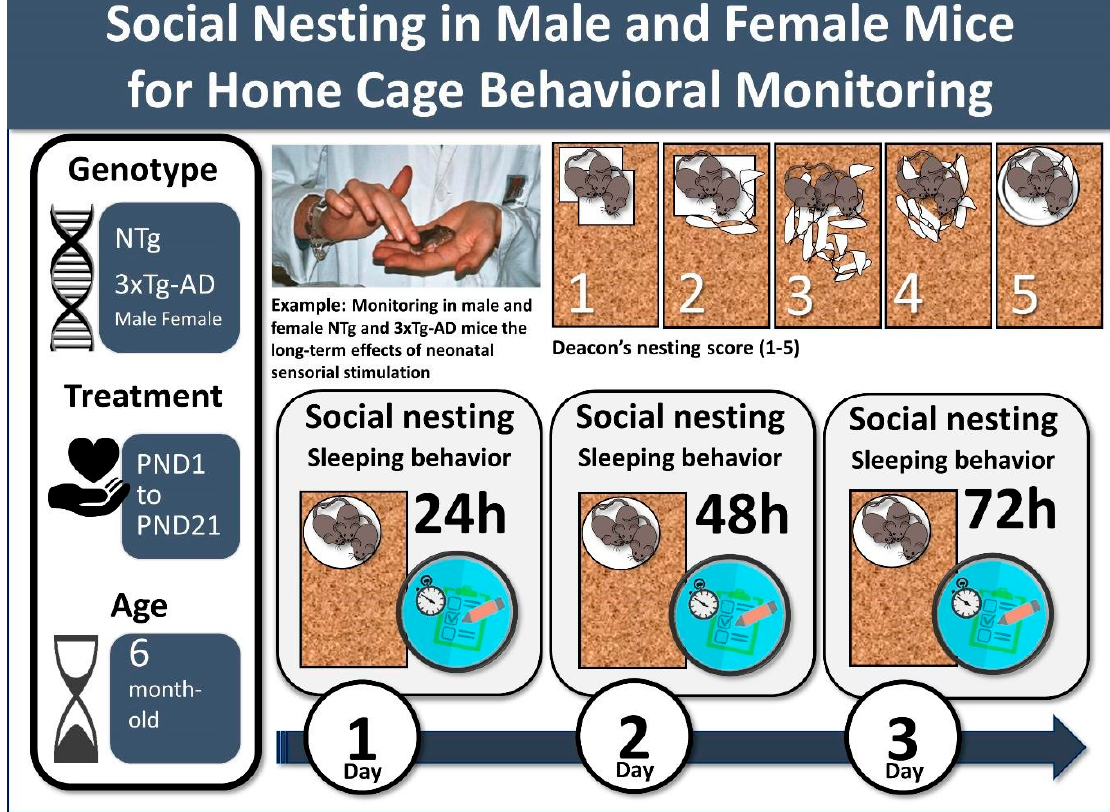
Figure 1. Social nesting in six-month-old male and female mice for home-cage behavioral monitoring in normal (NTg, non-transgenic) and AD-pathological aging (3xTg-AD mice), and the assessment of the long-term effects of neonatal tactile-proprioceptive sensorial stimulation administered from postnatal day 1 to 21.